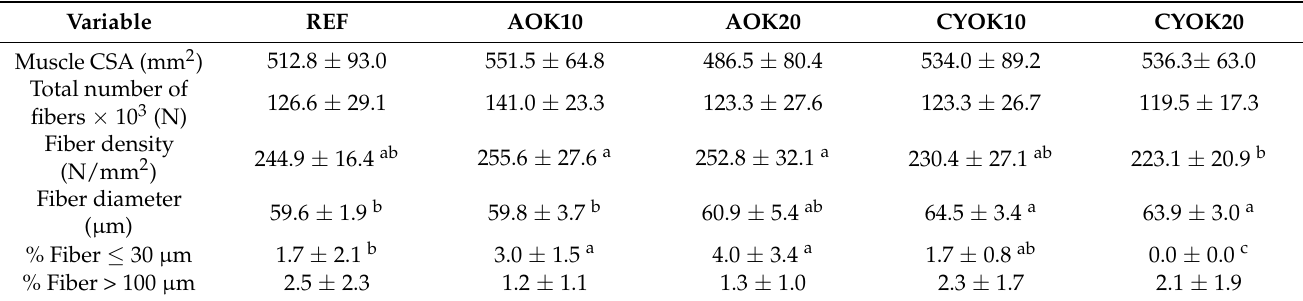
Table 8. Muscle cellularity of Nile tilapia fed the experimental diets for 10